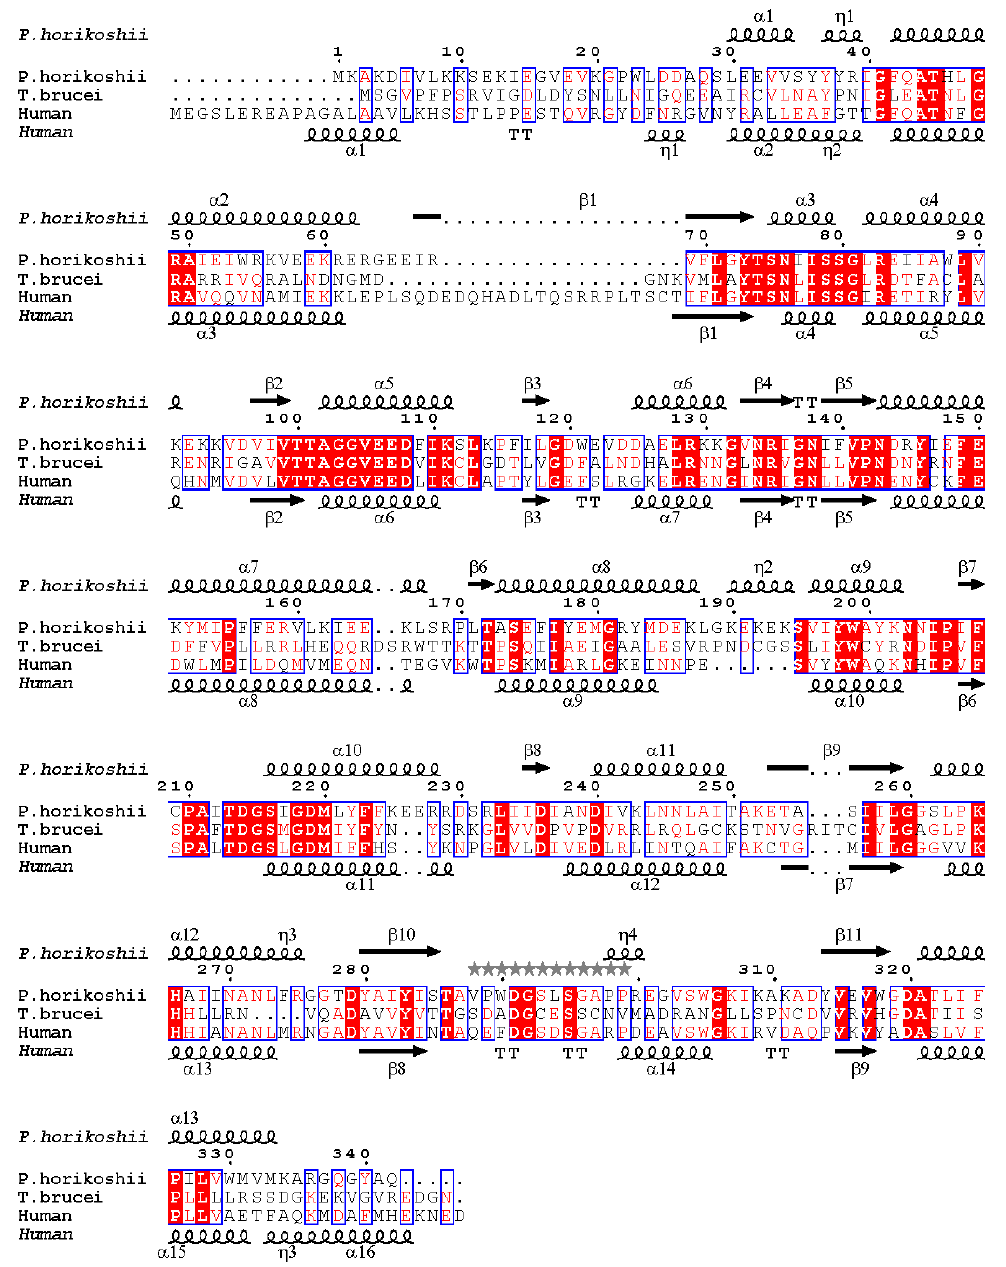
Figure 2. Sequence alignment of Pho DHS with DHS from human and T. brucei . The ESPript 3.0 server was used to output the alignment [28]. The blue box above the sequence indicates that the sequences of at least two out of three organisms share a similarity, while the sequences identical in all the three organisms are marked with red fills. The secondary structure shown by the respective crystal structures for Pho DHS and human DHS are labeled at the top and bottom, respectively. The loop 288–299 with alternative conformations is indicated with grey stars above.